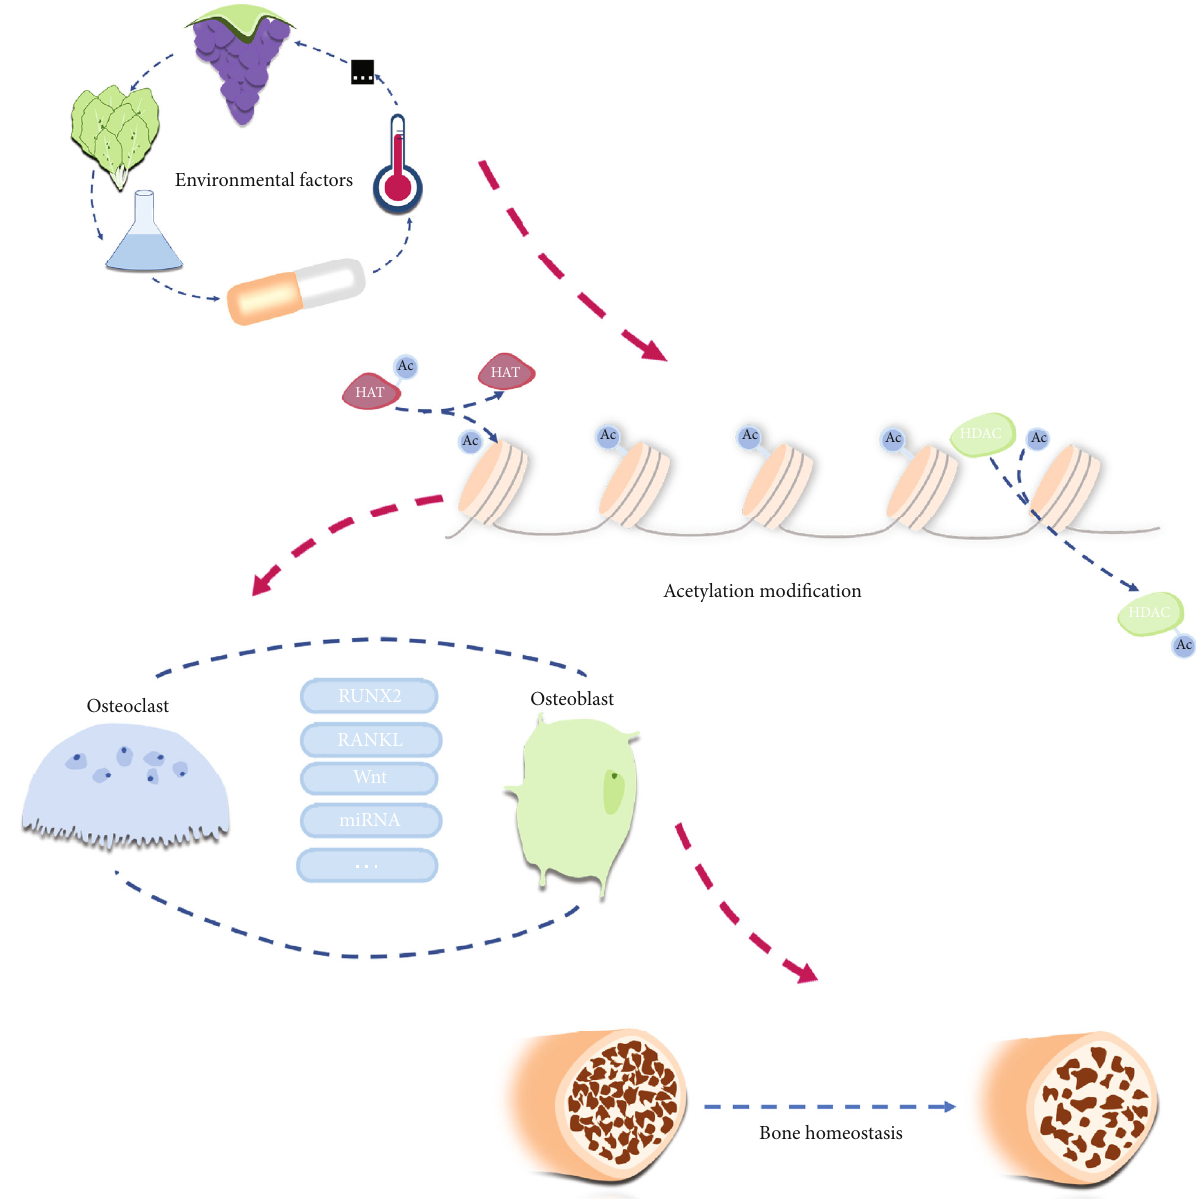
Figure 3: The cascade relationship of environment, acetylation, and bone